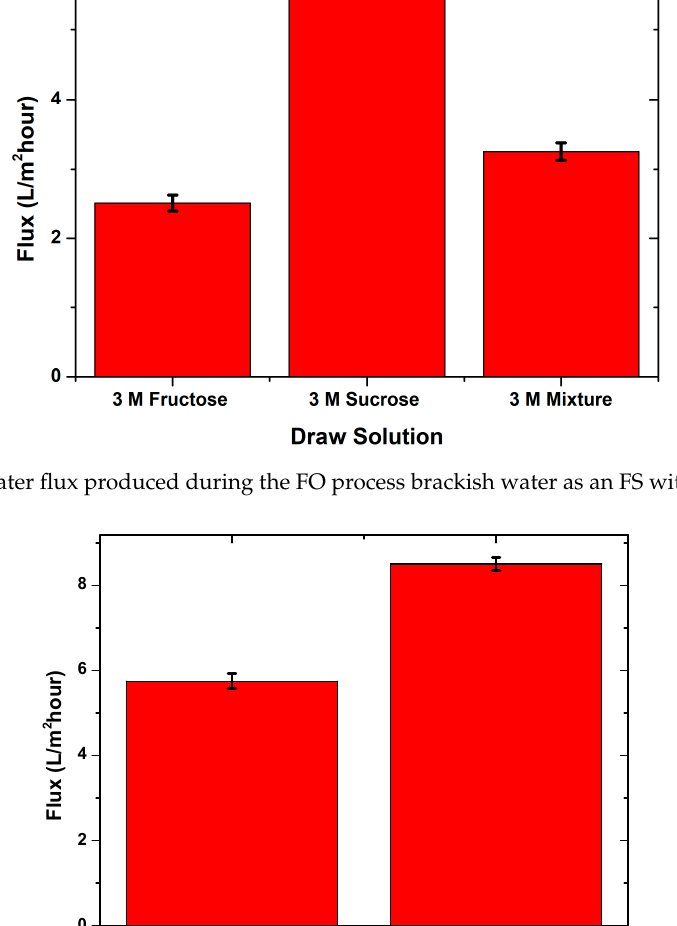
Figure 4. The resulting water flux used 3 M sucrose as a withdrawal solution with different FSs.